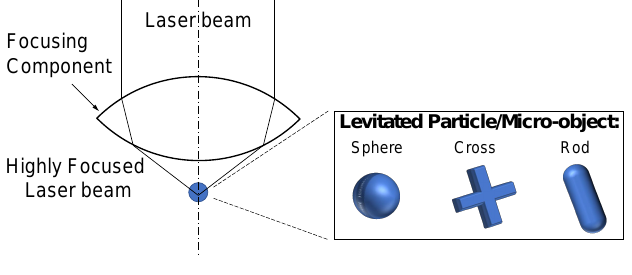
Figure 6. Schematic of a highly focused laser beam to create an optical trap and levitate particles or micro-objects. Particles or micro-objects of arbitrary shape (sphere, cross and rod) can be trapped in an optical